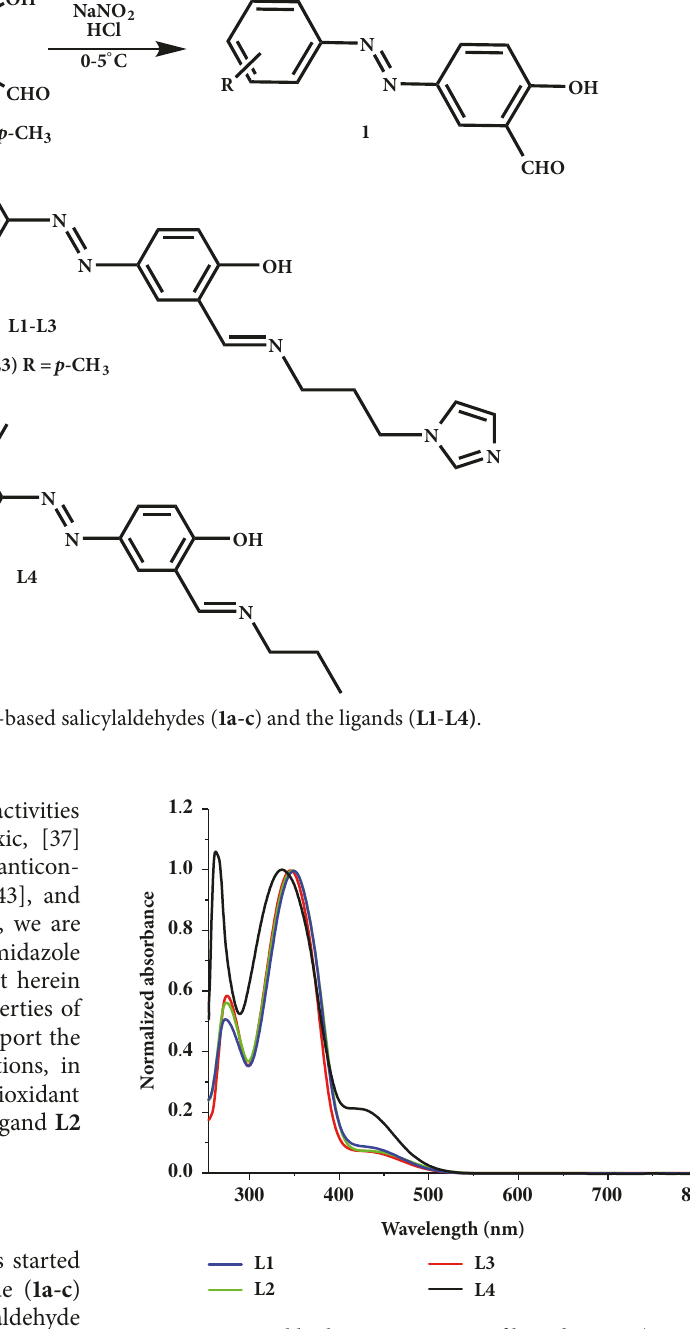
Figure 1: UV-visible absorption spectra of ligands L1-L4 (2 ⋅ 10 −5 M) in dichloromethane at room